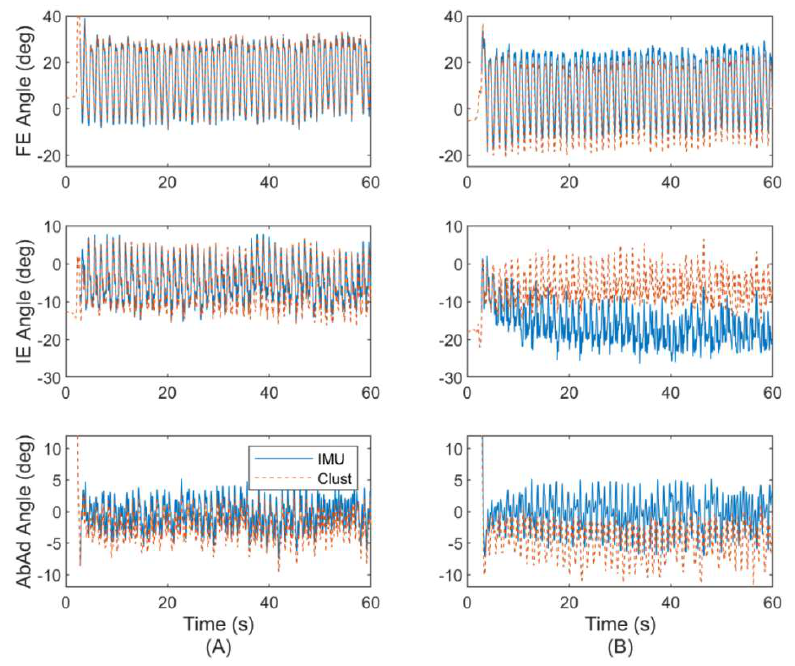
Figure 8. Comparison of estimated hip joint angles for representative subject between hips. Estimated hip joint angles for the left ( A ) and right ( B ) hips. Comparison is between ErKF (IMU) and cluster (Clust) methods. Offsets between estimation methods may converge despite error sources (B).